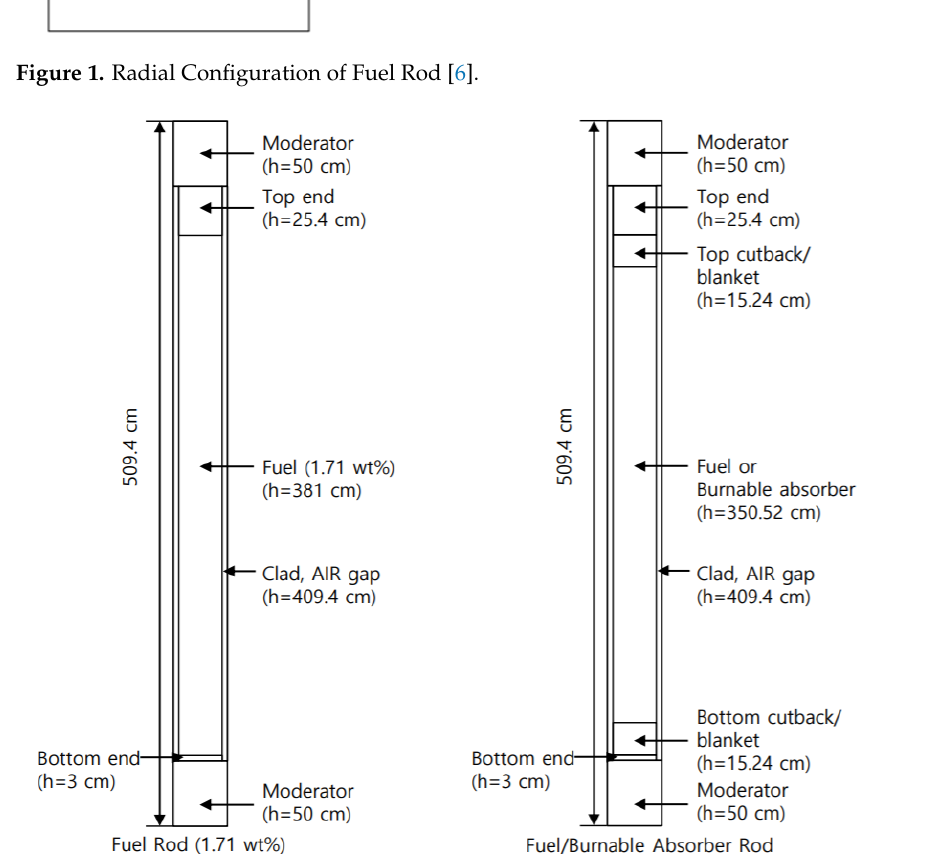
Figure 2. Axial Layout of Fuel and Burnable Absorber Rods in A0 Fuel Assembly ( Left ) and All Other Fuel Assemblies ( Right )